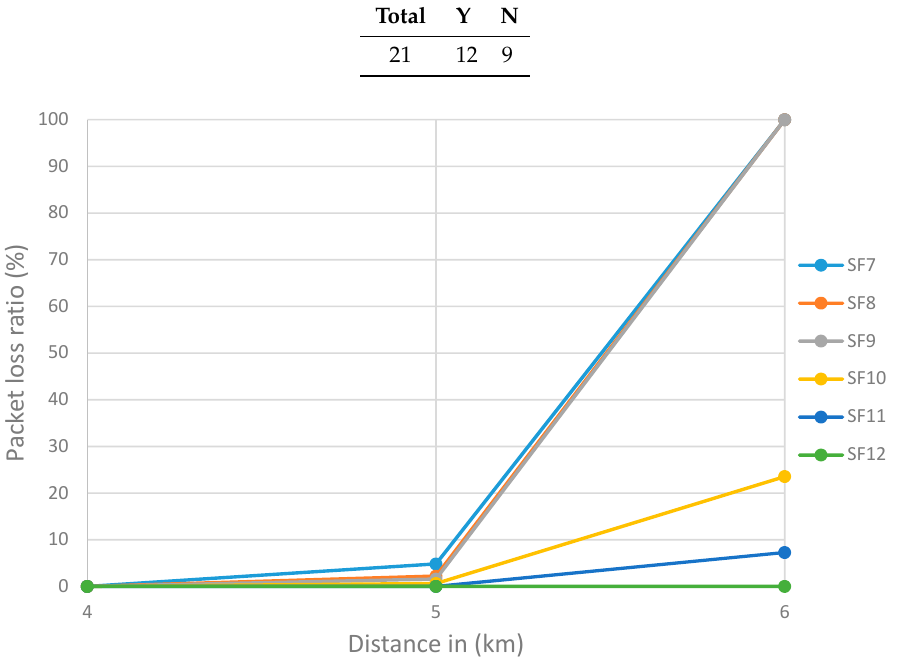
Figure 10. Correlation between SF and packet loss ratio.